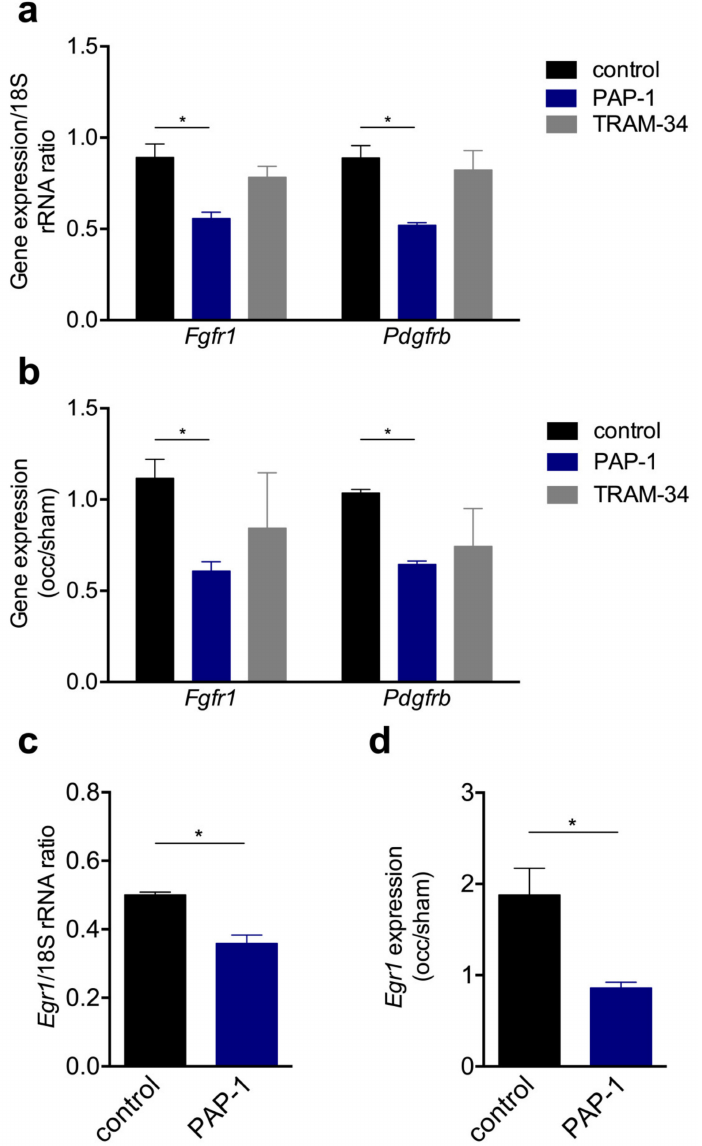
Figure 8. The qRT-PCR results of the expression levels of Fgfr1 , Pdgfrb, and Egr1 in vitro and during arteriogenesis in vivo. ( a , c ) Bar graphs represent the mRNA expression levels of Fgfr1, Pdgfrb, or Egr1 in vitro and ( b , d ) in vivo. In vitro mouse primary artery SMCs were cultured without (control) or with 1 µ M PAP-1 or 100 nM TRAM-34, respectively. In vivo the expression level of Fgfr1 , Pdgfrb, and Egr1 were investigated 12 h after induction of arteriogenesis in collateral arteries and are expressed as occlusion (occ) to sham ratio. All qRT-PCR results were normalized to the expression level of the corresponding 18S rRNA. Data are means ± SEM, n = 3 per group. * p < 0.05 from one-way ANOVA with Bonferroni’s multiple comparison